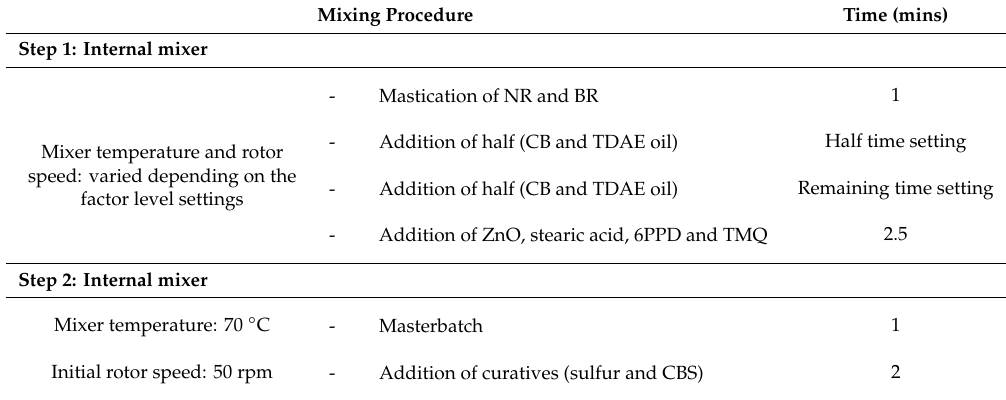
Table 3. The two-stage mixing